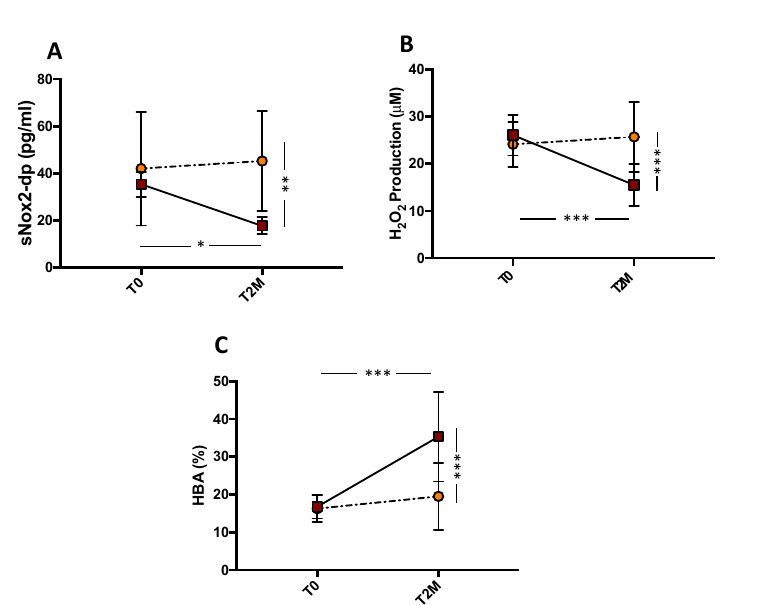
Figure 2. Serum soluble NOX2-derived peptide (sNOX2-dp) ( A ), serum H 2 O 2 ( B ), and blood HBA ( C ) before (T0) and 2 months (T2M) after mixture intake ( n = 10) or no-treatment ( n = 10) in peripheral artery disease patients. Data are expressed as mean ± SD. * p < 0.05, ** p < 0.01, *** p < 0.001.